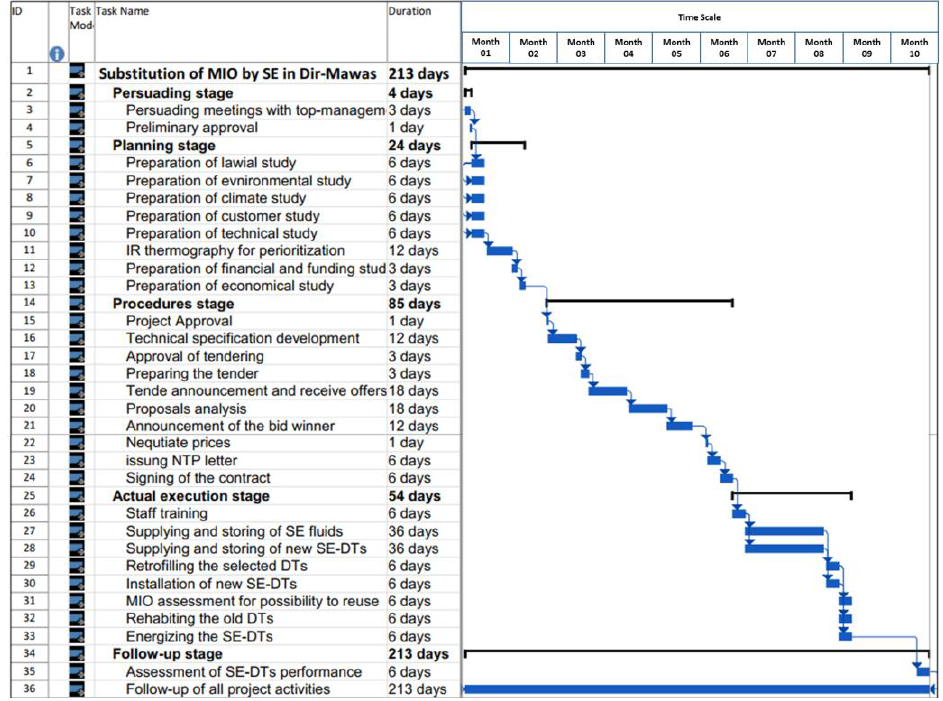
Figure 14. Gantt-chart for the project of substituting MIO by SE in Dir-Mawas.